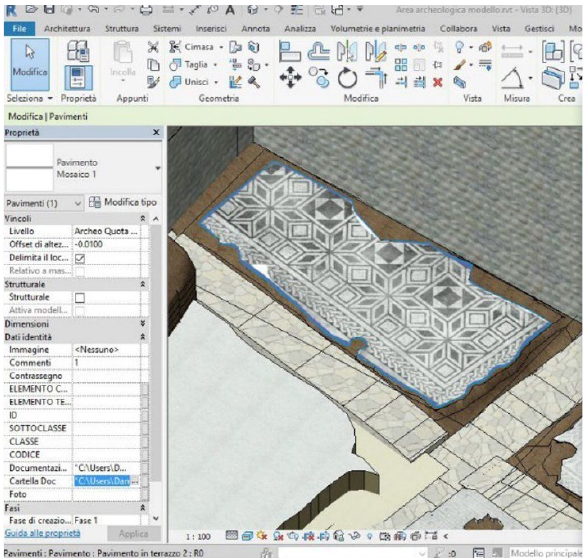
Figure 7: detail of the pavement with different layers (strata) and the mosaic orthophoto.